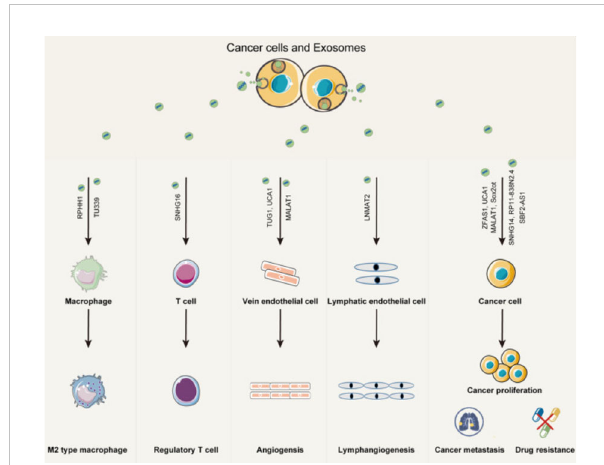
FIGURE 3 Exosomes play an important role in mediating the interaction between cancer cells and both immune cells and stromal cells within the cancer microenvironment. Exosomal lncRNAs from cancer cells can promote immune modulation, angiogenesis, cancer proliferation, metastasis, and drug resistance